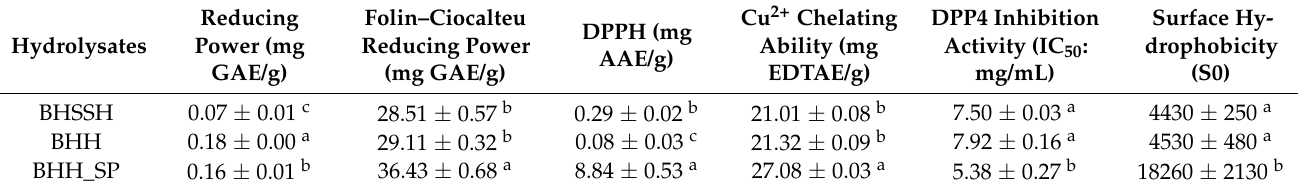
Table 3. Antioxidant, DPP4 inhibition, and surface hydrophobicity properties of Baltic herring